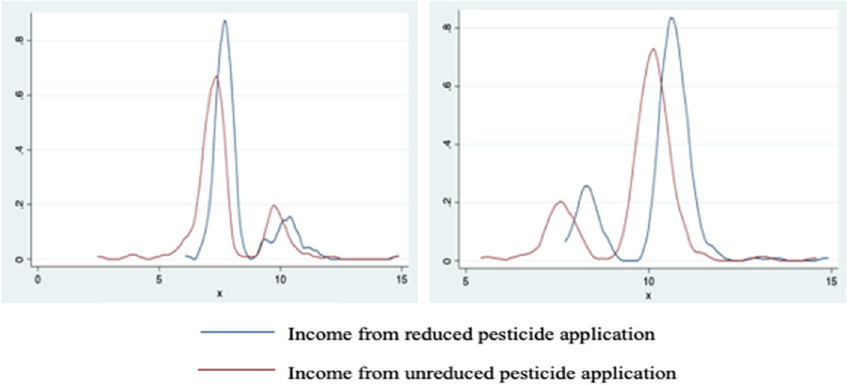
Figure 3. Effects of the pesticide application behavior on the income of rice farmers and rice output.